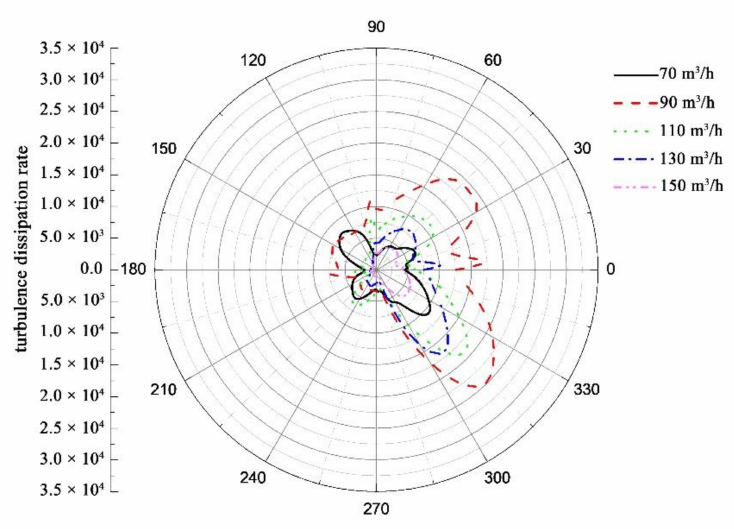
Figure 18. The variation of the circumferential turbulence dissipation rate at the outlet section hub within the first impeller under different flow